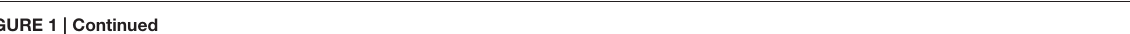
FIGURE 1 | Continued to the corresponding ε L-W -value. Thick, horizontal, dark gray, dashed lines indicate the group average (e.g., heterotrophic aerobic respiration). The range of abundance-weighted average ε L-W for each strain is shown on the far right. (B) Vertical colored bars indicate the total compound-specific range for each substrate condition. Compound-specific data is plotted in Figure S1. Black bars on the far right illustrate the total range of compound specific data for aerobic respiration, nitrate reduction, and sulfate reduction,